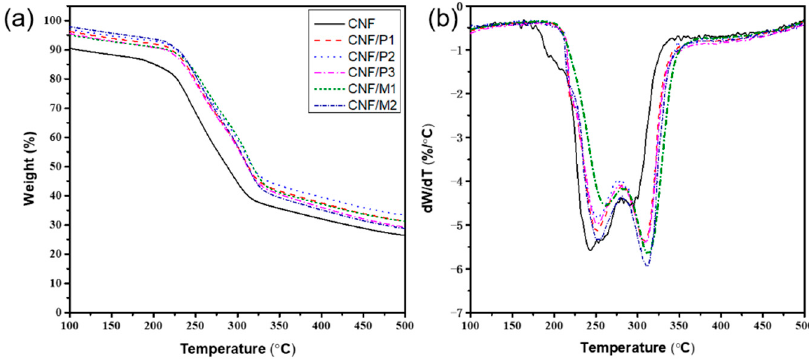
Figure 4. ( a ) TG and ( b ) DTG curves of pure CNF film and different composite films.